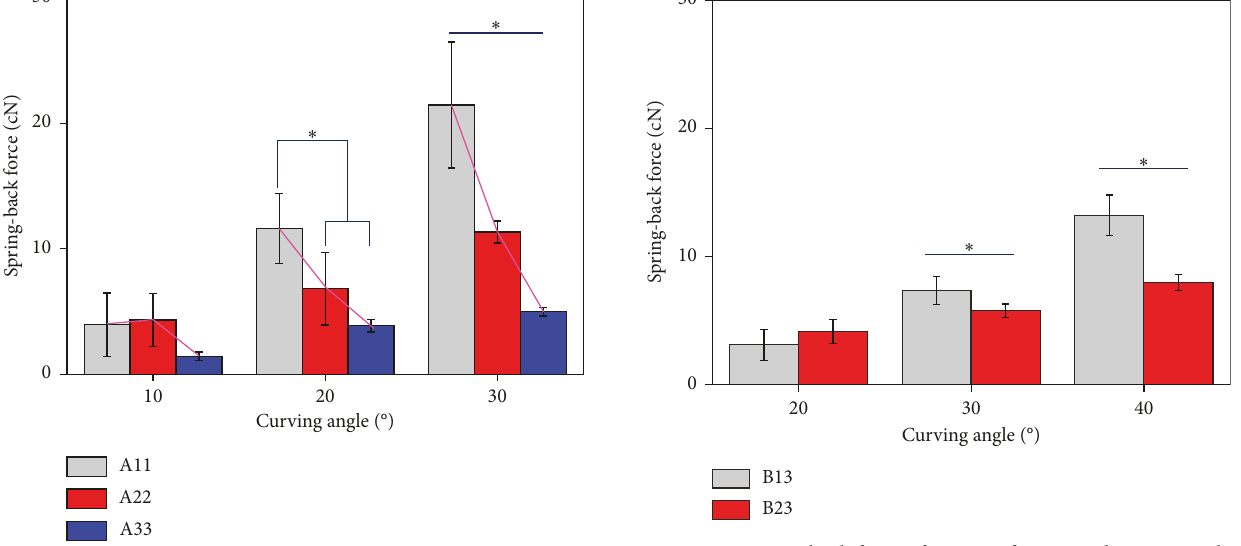
Figure 9: Spring-back force of stent grafts A11, A22, and A33 with the same curving